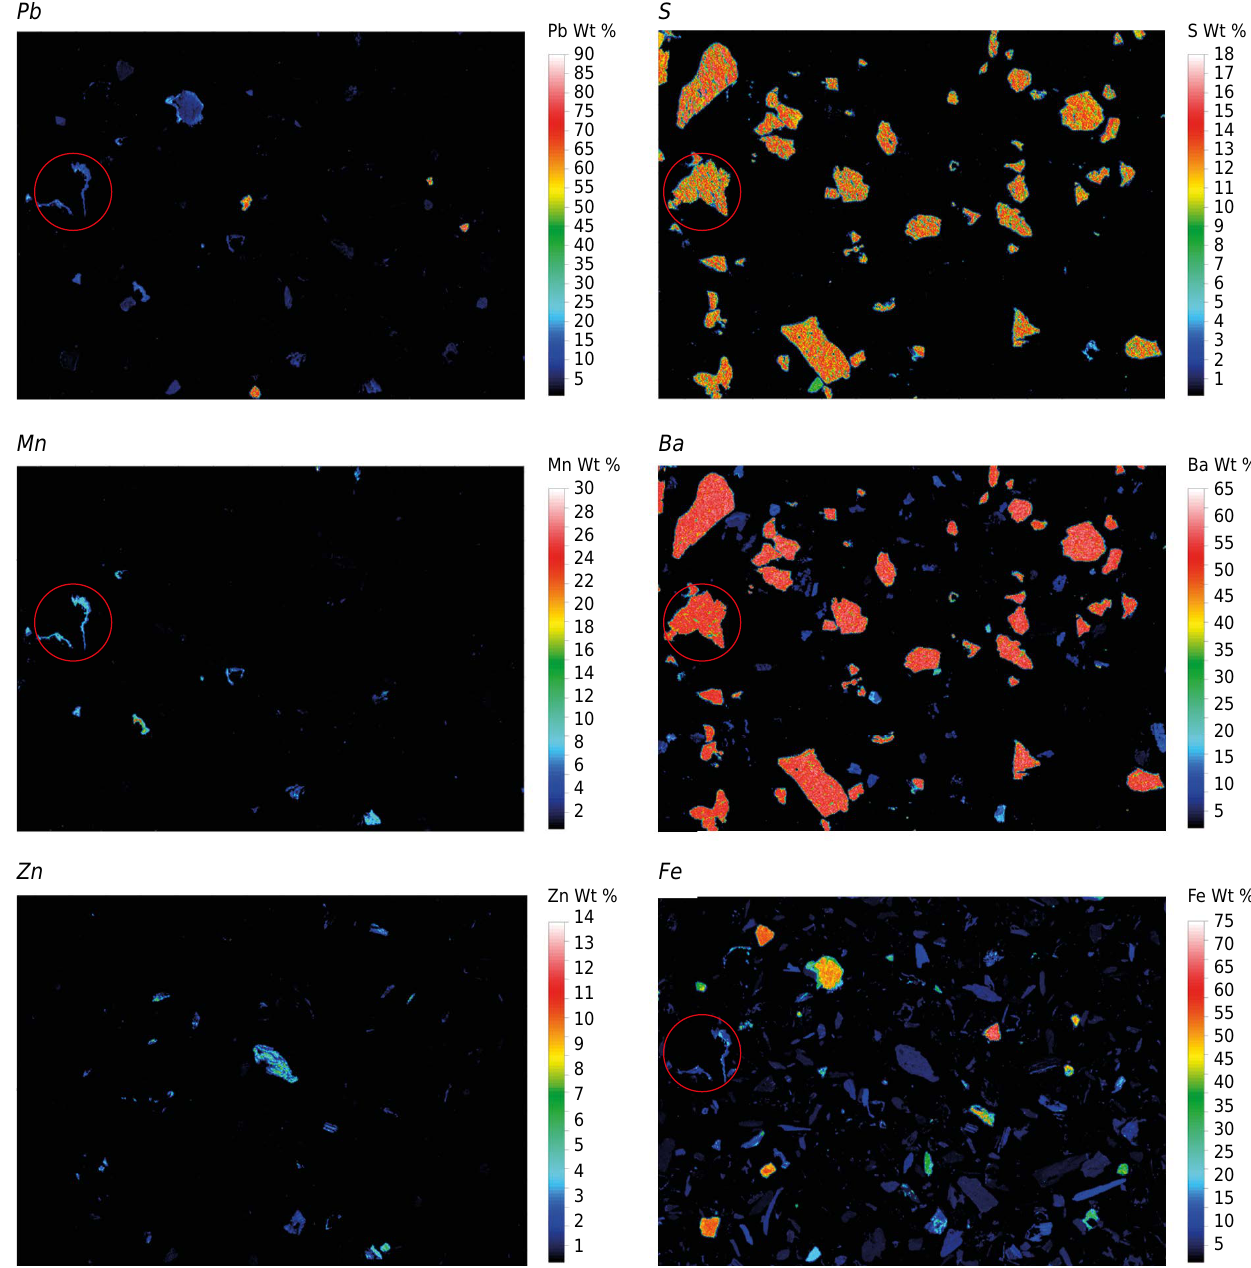
Figure 9. Elemental maps showing chemical distribution in polished sand sample 23. The precipitation of Pb-Mn-Fe around the barite (BaSO 4 ) is highlighted inside the red